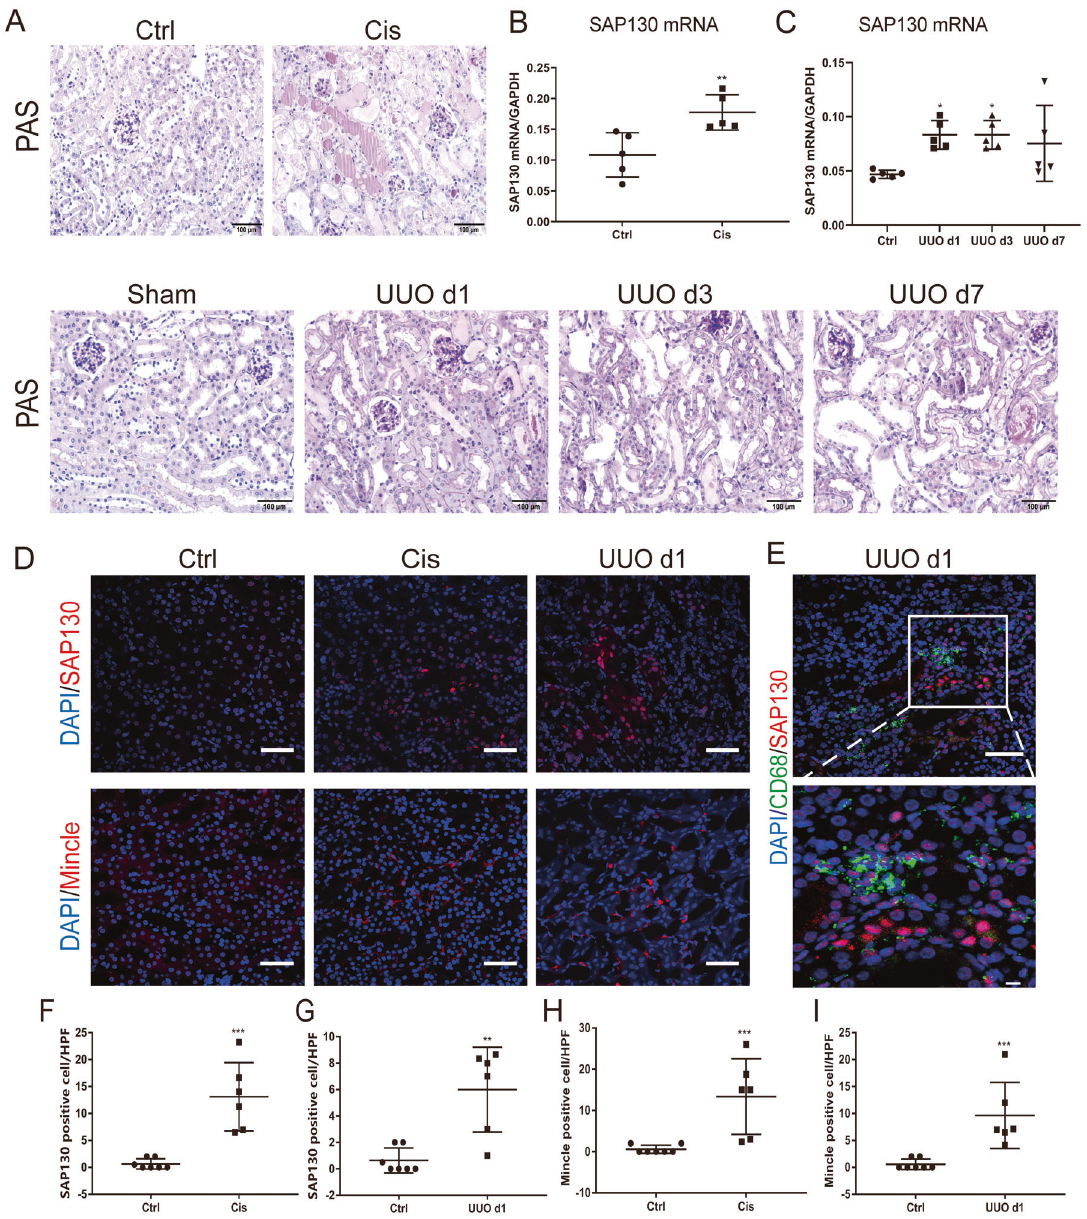
Fig. 1 Correlation between SAP130 and Mincle expression in mouse model of acute kidney injury. A Acute kidney injury (AKI) was induced by unilateral ureteral obstruction (UUO) and cisplatin injection in mice. Scale bar, 100 μ m. B – C SAP130 expression was increased in AKI mice compared to controls as detected by RT-PCR. D Immuno fl uorescence staining showed increased cytoplasmic SAP130 expression which is evident in tubules of the injured kidney, accompanying with upregulated expression of Mincle. Scale bar, 50 μ m. E Confocal microscopy showed that CD68 + macrophages (green) were surrounded to the area of tubules with strong SAP130 expression (red). Scale bar, 50 μ m. F – I Quantitative analysis of SAP130 and Mincle positive cells. Data were presented as mean ± SD. * p < 0.05, ** p < 0.01, *** p < 0.001 compared to Ctrl. Ctrl Control, Cis